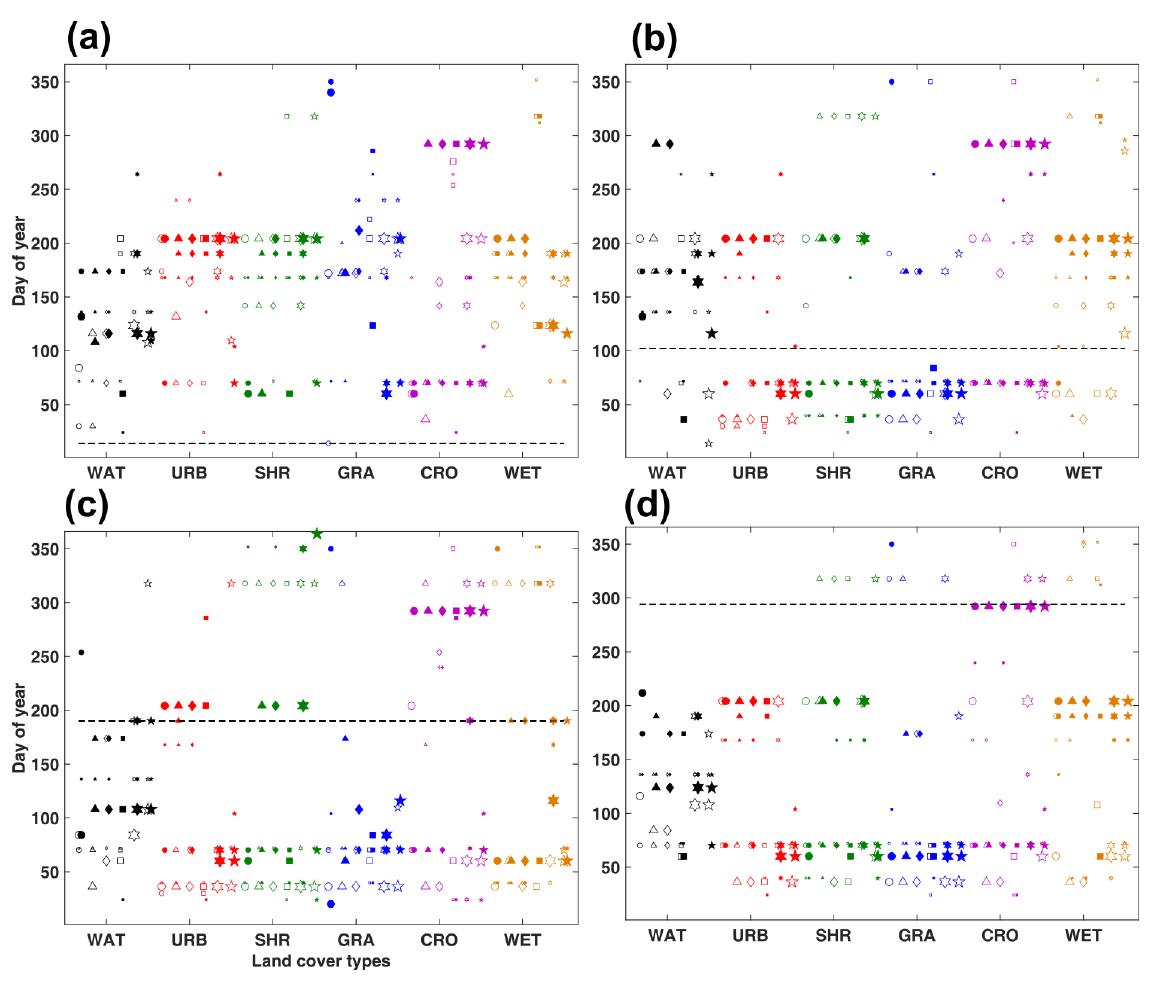
Figure 6. Distribution of the day of year (DOY) for minimum R 2 (not filled marker) and maximum RMSE (filled marker) value for year 2001, 2003 and 2008. The corresponding simulation date (dash line) is ( a ) 14 January (DOY: 14), ( b ) 12 April (DOY: 102), ( c ) 9 July (DOY: 190) and ( d ) 21 October (DOY: 294) for year 2009, respectively. The size of marker from small to big denotes year 2001, 2003 and 2008